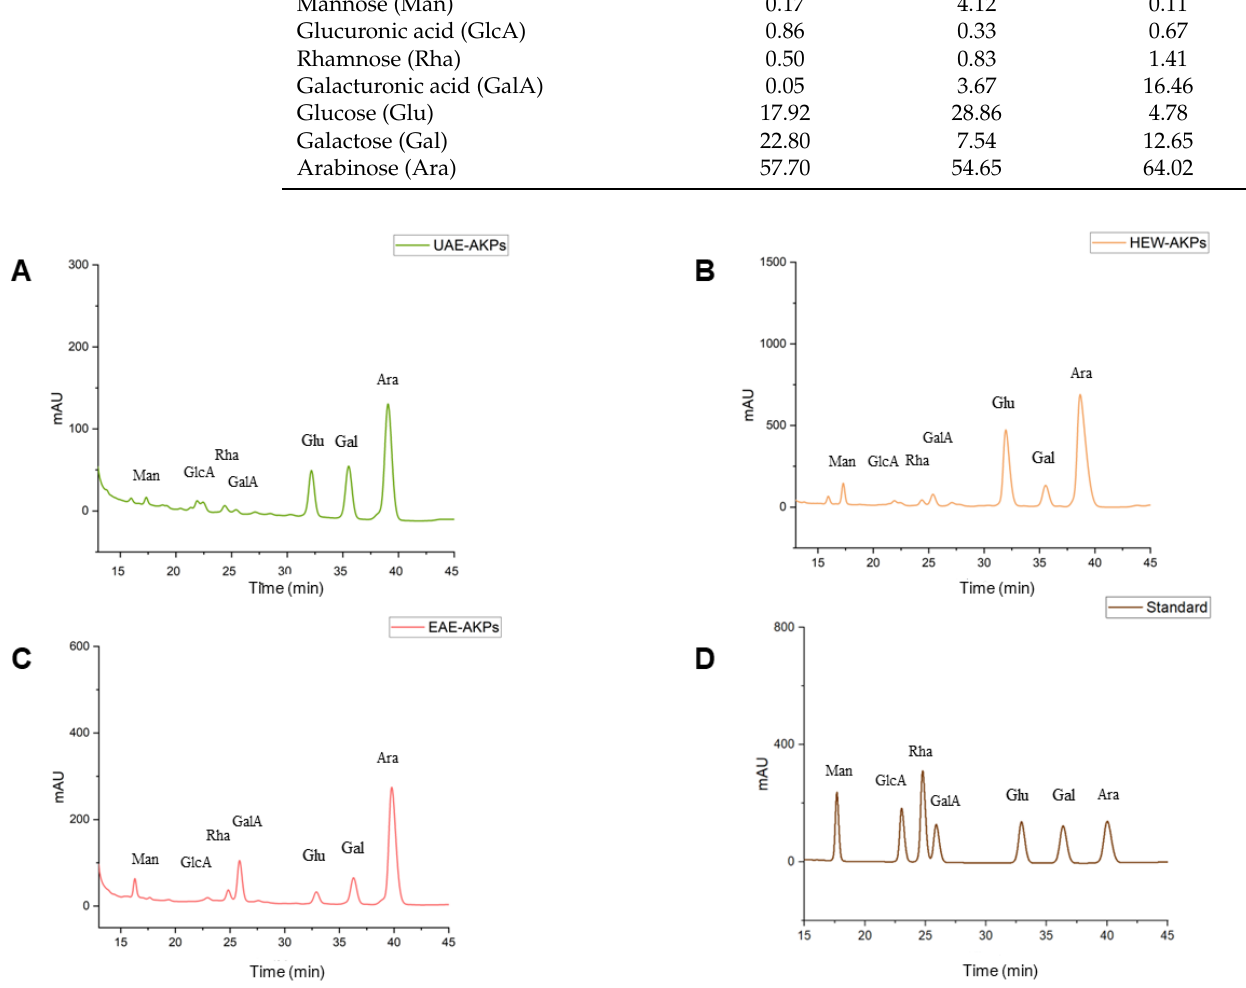
Figure 3. HPLC chromatogram for monosaccharide composition: UAE-AKPs ( A ), HWE-AKPs ( B ), EAE-AKPs ( C ) and standard monosaccharides ( D ) . Mannose (Man); glucuronic acid (GlcA); rham- ( B ), EAE-AKPs ( C ) and standard monosaccharides ( D ). Mannose (Man); glucuronic acid (GlcA); nose (Rha); galacturonic acid (GalA); glucose (Glu); galactose (Gal); arabinose (Ara). rhamnose (Rha); galacturonic acid (GalA); glucose (Glu); galactose (Gal); arabinose